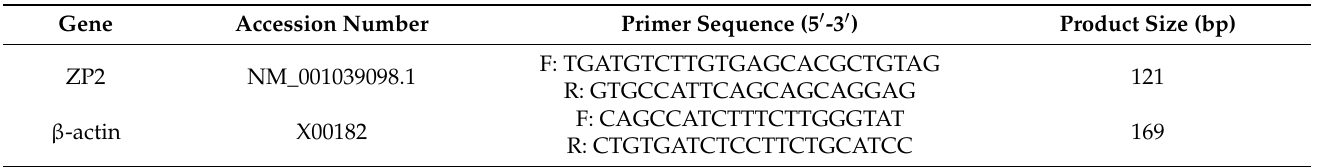
Table 1. qRT-PCR primers and